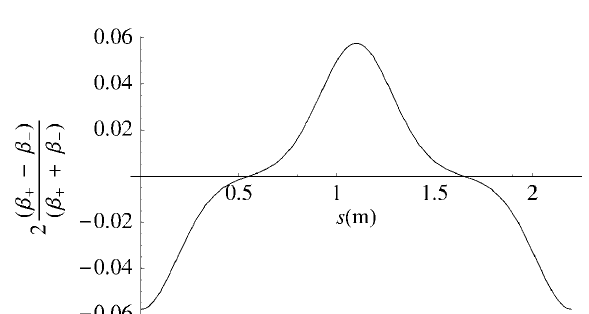
FIG. 4. Relative difference in lattice